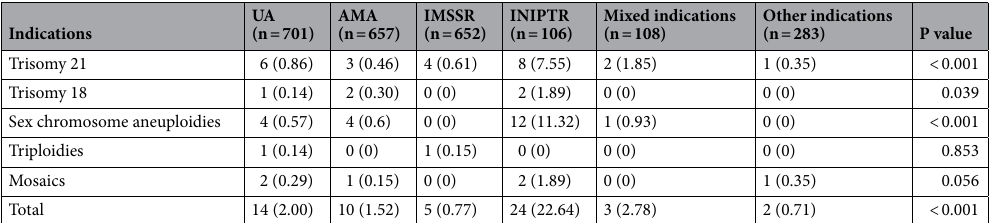
Table 3. Numerical chromosomal abnormalities in pregnancies with different indications. UA, ultrasound abnormalities; AMA, advanced maternal age; IMSSR, increased maternal serum screening risk; INIPTR, increased NIPT risk. Other indications included previous fetus/child with genetic or phenotypic abnormalities, carriers of monogenic genetic diseases, medication during pregnancy, embryos stop developing, intellectual disability of pregnant women. Case numbers and percentages for these numbers were listed in the